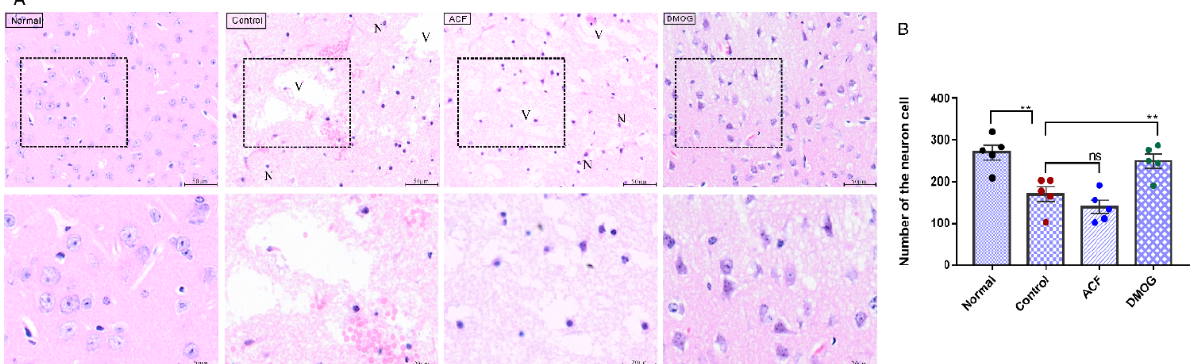
Figure 4. HIF-1 α activation rescues neuron cells during cerebral ischemia. ( A ) H&E staining sections. Neuronal degeneration [N], vacuolated adjacent tissue [V]. ( B ) The number of neuron cells. Control vs. Normal: ** p < 0.01, ACF vs. Control: p = ns, DMOG vs. Control: ** p < 0.01. 50 μ m &20 μ m. All values are expressed as mean ± SEM, one-way ANOVA, followed by post hoc Tukey test, n = 5.